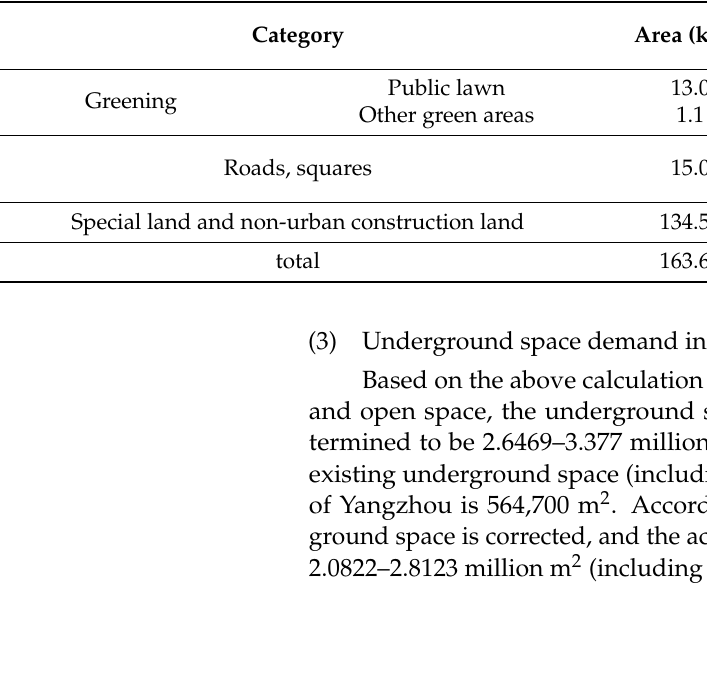
Table 14. Underground space demand of open space.